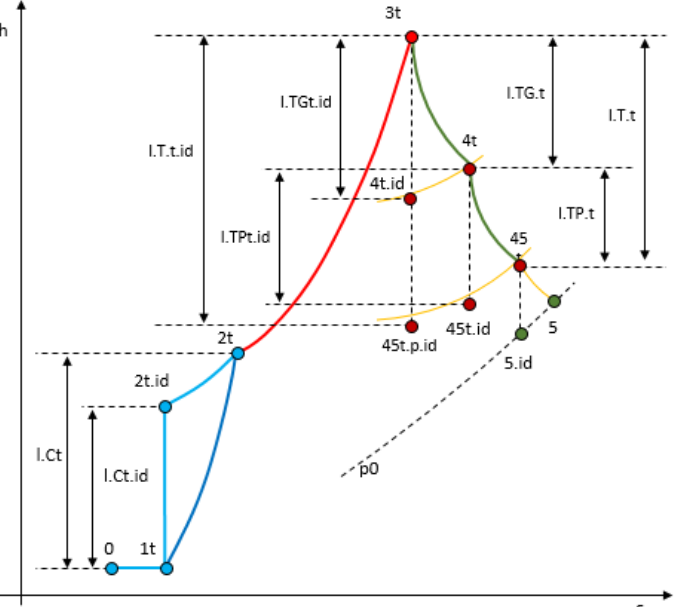
Figure 10. TV2-117A engine cycle diagram.